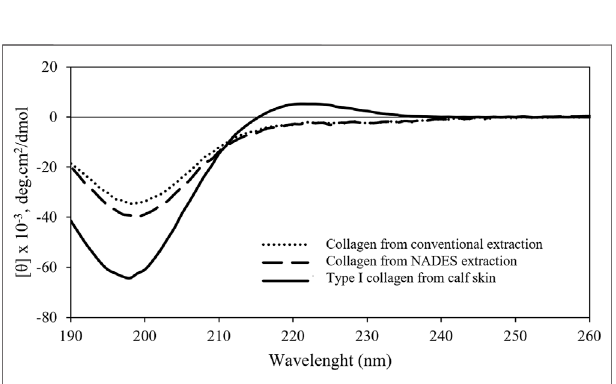
FIGURE 4 | FTIR spectra of the collagen extracts obtained from blue shark skins with conventional solvent and NADES and collagen standard from calf skin, exhibiting the main vibrations of collagen molecular organization, amide A, amide I, amide II, and amide III.